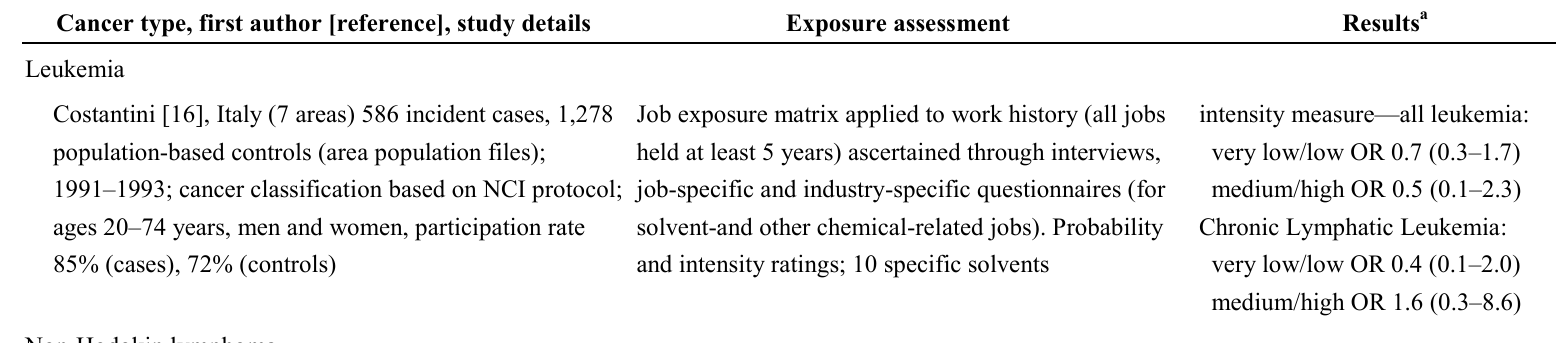
Table 2. Summary of case-control studies of hematopoietic cancer risk and dichloromethane